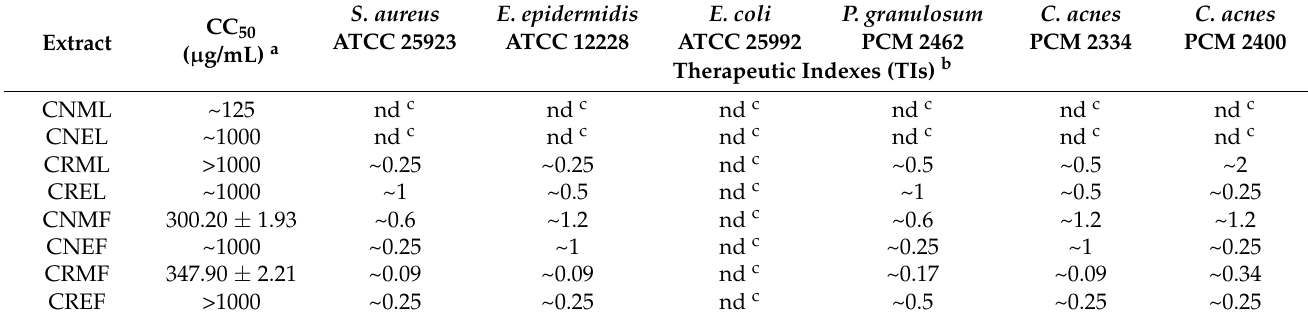
Table 7. The cytotoxic effect of the extracts obtained from the leaves and fruits of C. nebrodensis (CNML, CNEL and CNMF, CNEF) and C. roseus (CRML, CREL and CRMF, CREF) (CC 50 ) and calculated therapeutic indexes (TIs). The CC 50 value were expressed as mean values ± SD from three separate